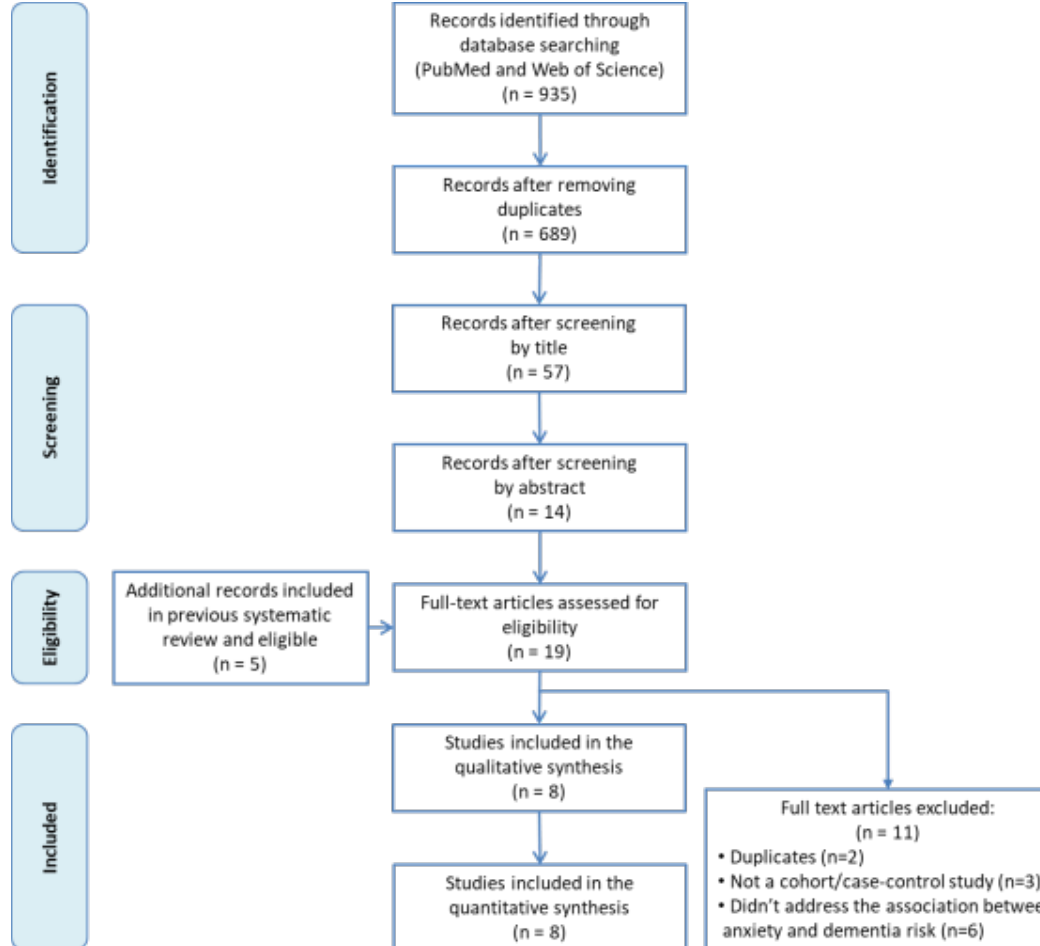
Figure 1. Flow chart of the literature search strategy and study selection process.